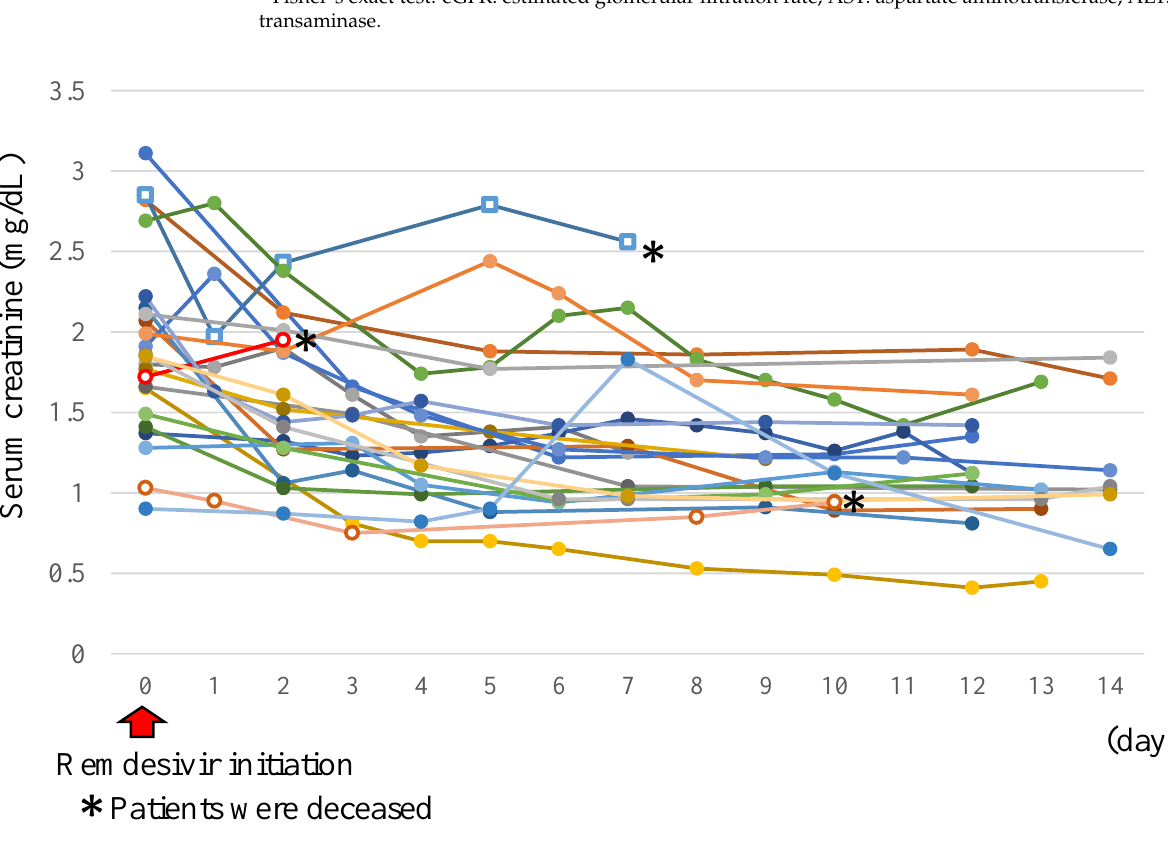
Figure 1. Trend data of serum creatinine in patients with eGFR < 30 mL/min with remdesivir